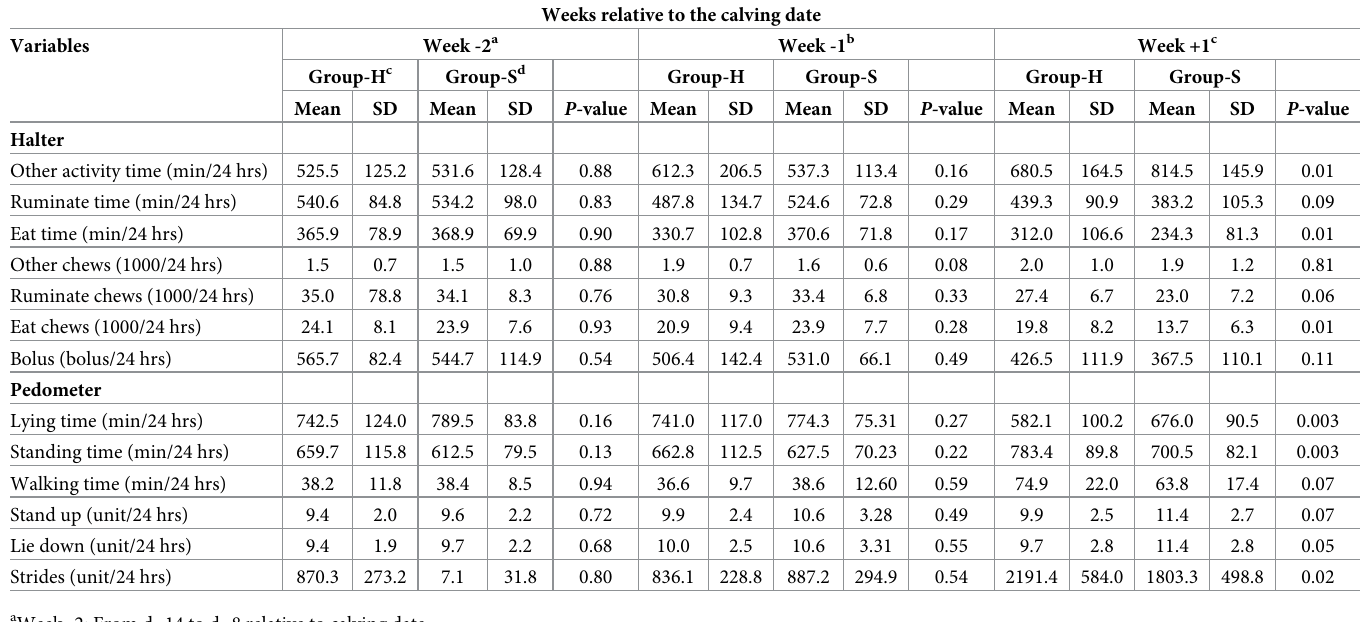
Table 3. Mean values of variables of RumiWatch 1 halters and pedometers of group-H and group-S at weeks -2, -1 and +1 relative to caving. Weeks relative to the calving